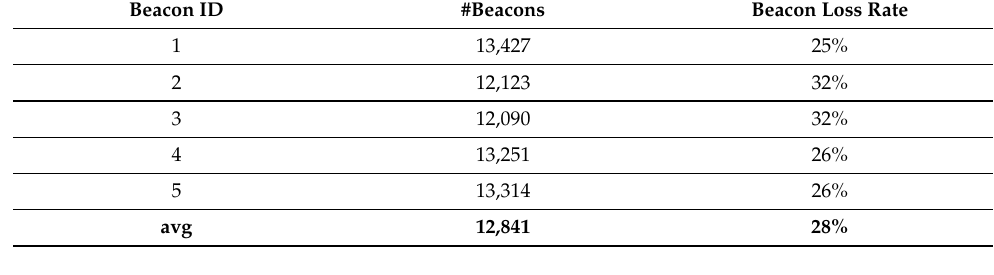
Table 4. Results of stress test T 1 .